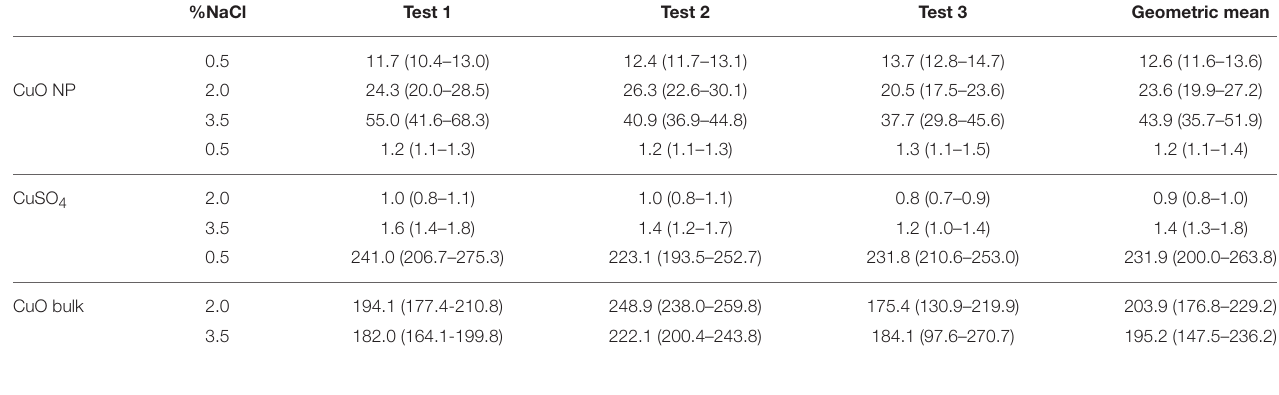
TABLE 2 | Mean effect concentration (EC 50 ) (mg/l) and 95% Confidence Limits of CuO NP, CuSO 4 5 H 2 O and CuO bulk calculated from three tests at three different salinities ( T = 25 ◦ C, 0.5-2.0-3.5% NaCl).